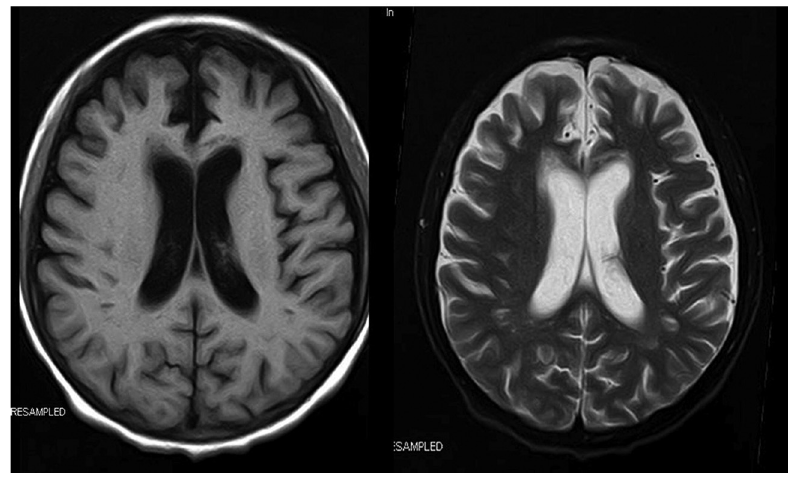
Figure 3: Brain MRI indicated cerebral atrophy after liver